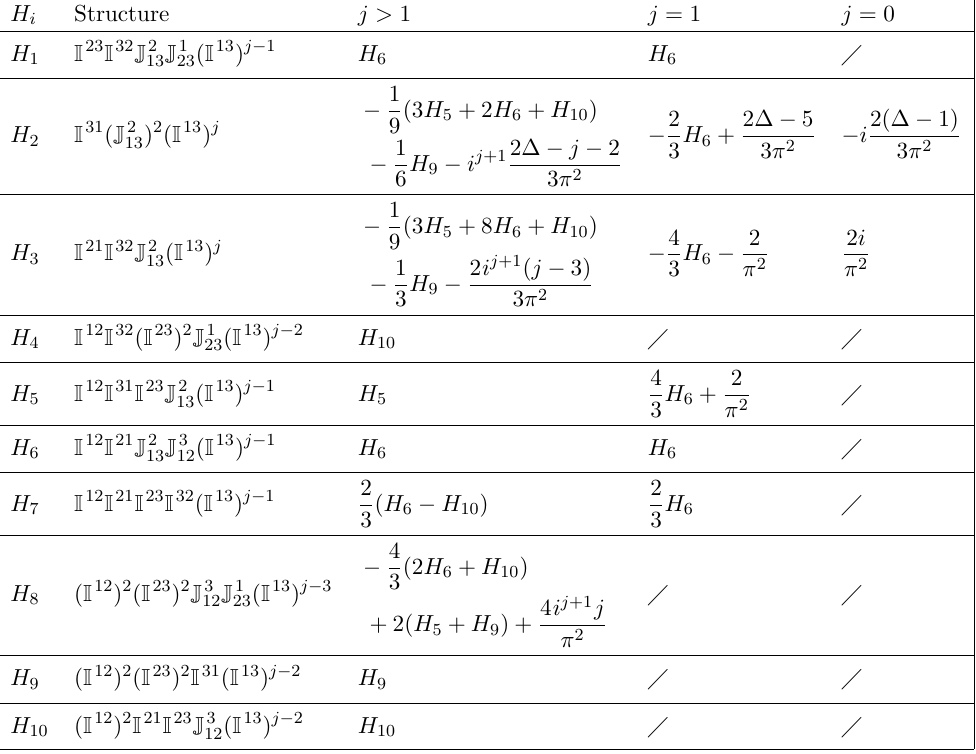
Table 6 . Ward identities of the stress tensor for the correlator dimension (cid:1) + 1 H k must be rescaled by c